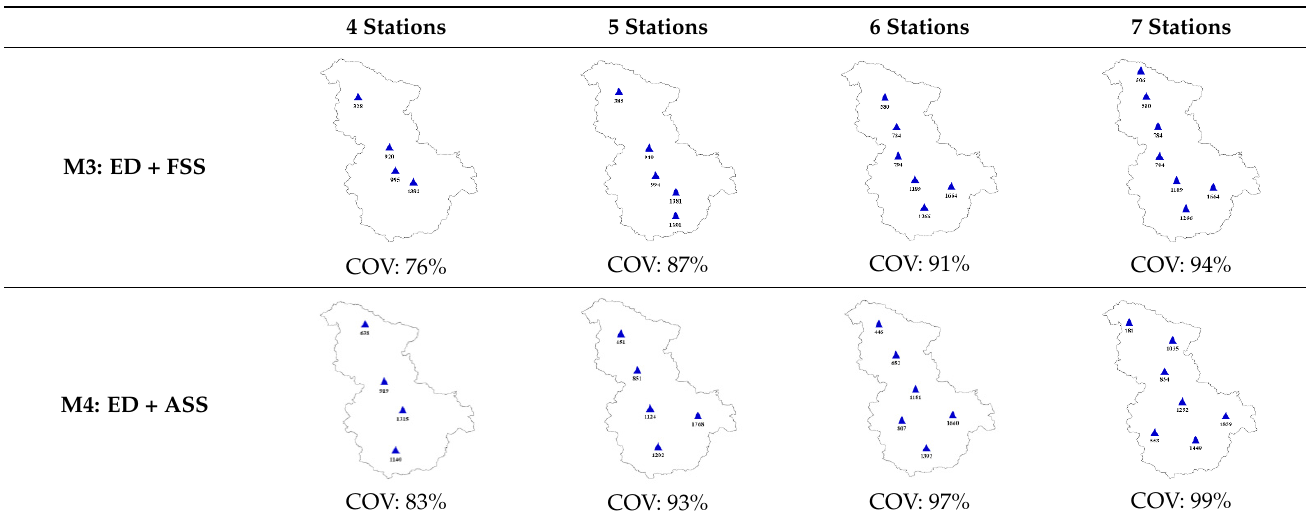
Table 5. Location of stations within the cities and coverage percentage.